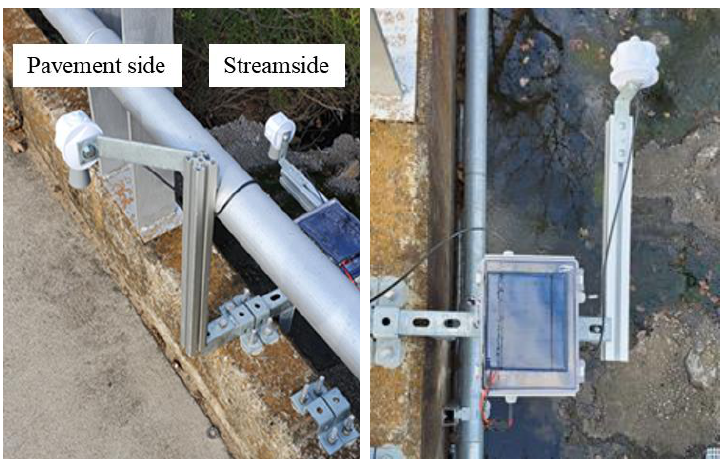
Figure 4. Installation of UWLD-2 system to monitor the water level on ( left ) the pavement side and streamside and ( right ) the streamside.